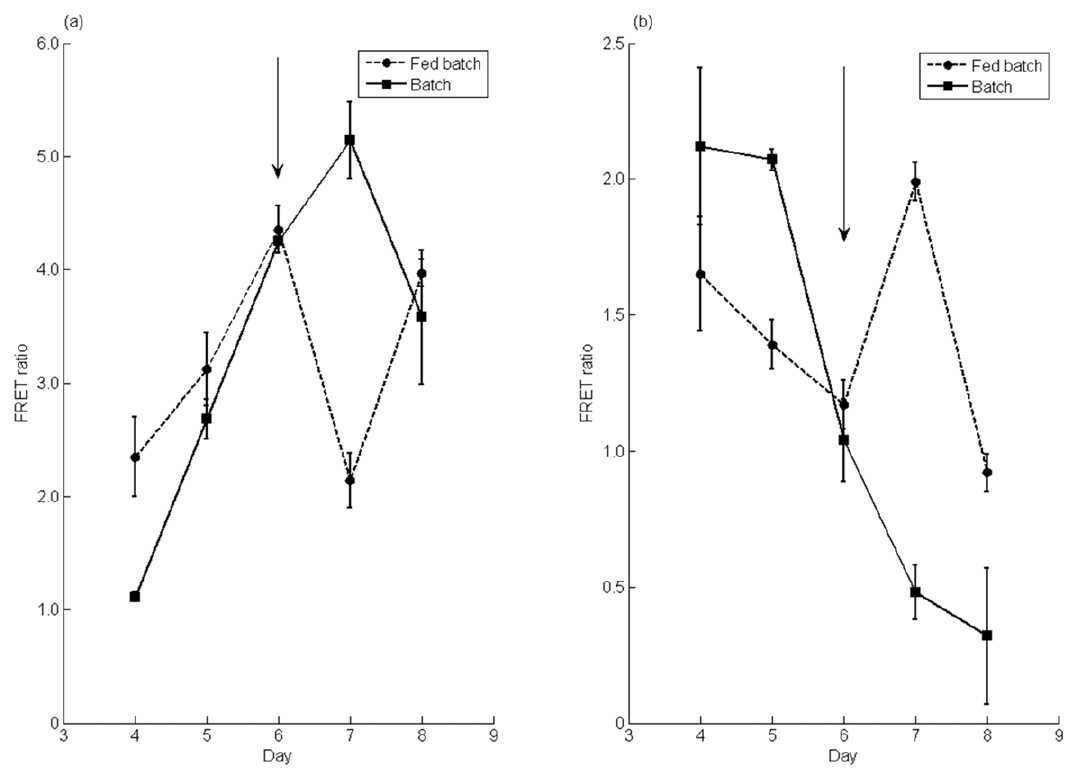
Figure 6. Fed batch culture of CHO-S cells and corresponding FRET measurements. a) Glucose fed-batch monitoring. Comparison of cells fed with glucose on day 6 (gray circles) and those given an equal volume of pure water (black squares). Arrow indicates addition of bolus feed to bring glucose concentration to 36 mM. b) Glutamine fed-batch monitoring. Comparison of cells fed with glutamine on day 6 (gray circles) and those given an equal volume of pure water (black squares). Arrow indicates addition of bolus feed to bring glutamine concentration to 4 mM. n=3. Error bars represent one standard deviation of the mean.